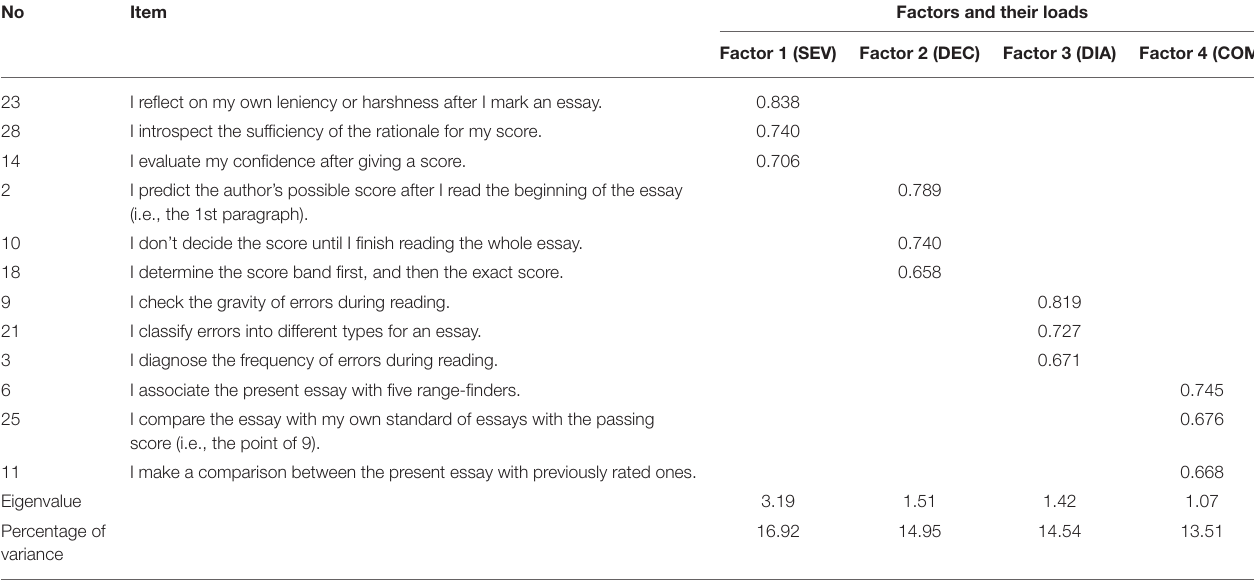
TABLE 2 | The results of exploratory factor analysis (EFA).